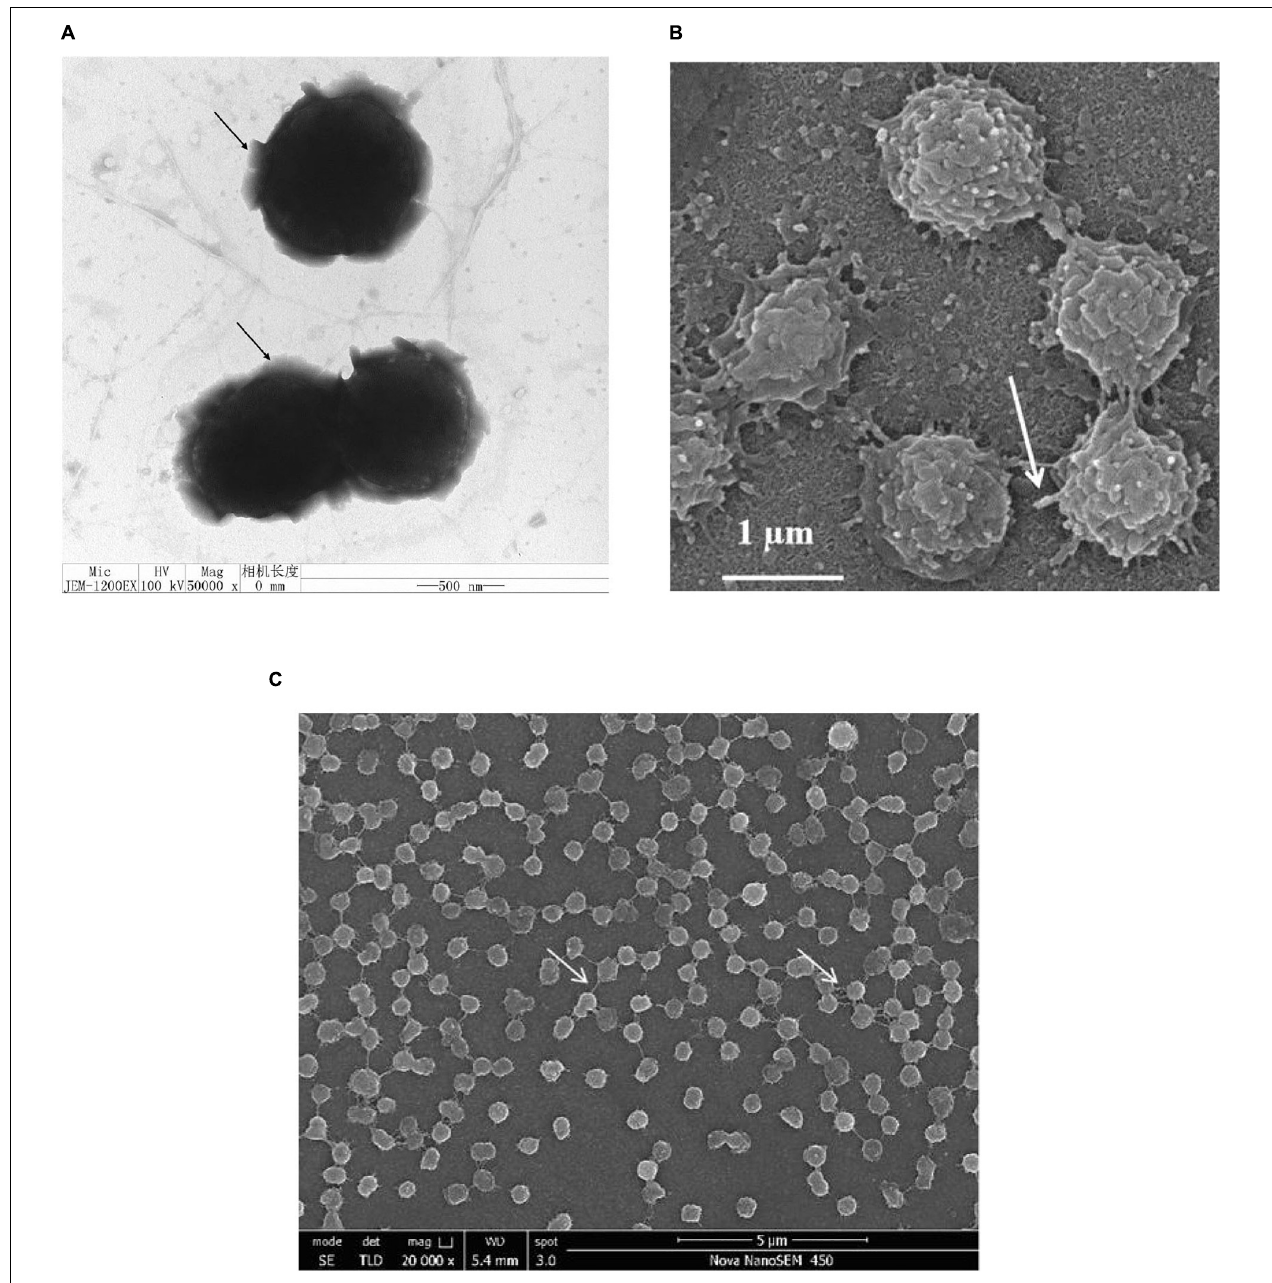
FIGURE 2 | Shape and ultrastructure of cells of strain NFK12 T . Cells were grown in MB at 33 ◦ C for 2 days. (A) Transmission electron microscopy. Arrows in panel a indicate ‘capsular’ EPS around the cells. Scale bar, 0.5 µ m. (B) Scanning electron microscopy. Arrows indicate randomly distributed finger-like extensions from which fimbriae appendages. Scale bar, 1.0 µ m. (C) Scanning electron microscopy. Arrows indicate ‘bridge’ extracellular polysaccharides (EPS). Scale bar, 5.0 µ m.